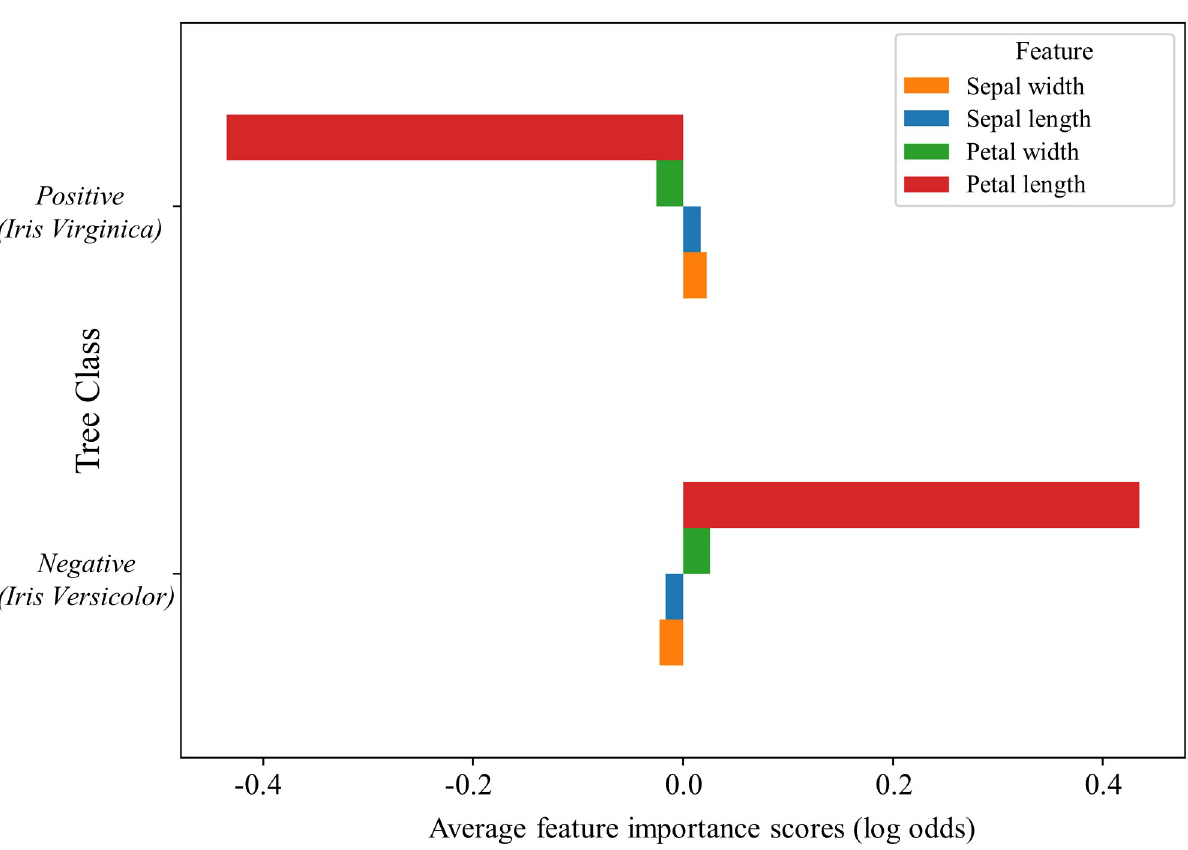
Fig 3. Average feature contribution weight per prediction in a single decision tree. After entering the Iris dataset into our linearized decision tree, we found the most important feature for successfully determining positive or negative class to be ‘petal length’. Importantly, the outputs provided in this analysis are given a magnitude and direction for their respective involvement in classification compared to other features. These metrics offer a significant improvement on previous analyses, whilst remaining consistent with the findings of Gini and permutation importance, where ‘petal length’ had the highest and second highest weightings respectively. Note that this represents the output data from a single decision tree (fold) prior to cross- validation.